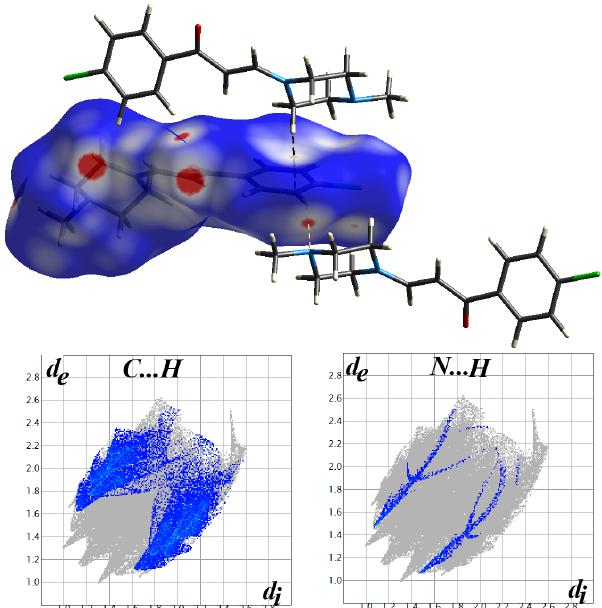
Figure 7. The fingerprint (lower) and d norm map (upper) of the C…H and N…H contacts in compound 2 .